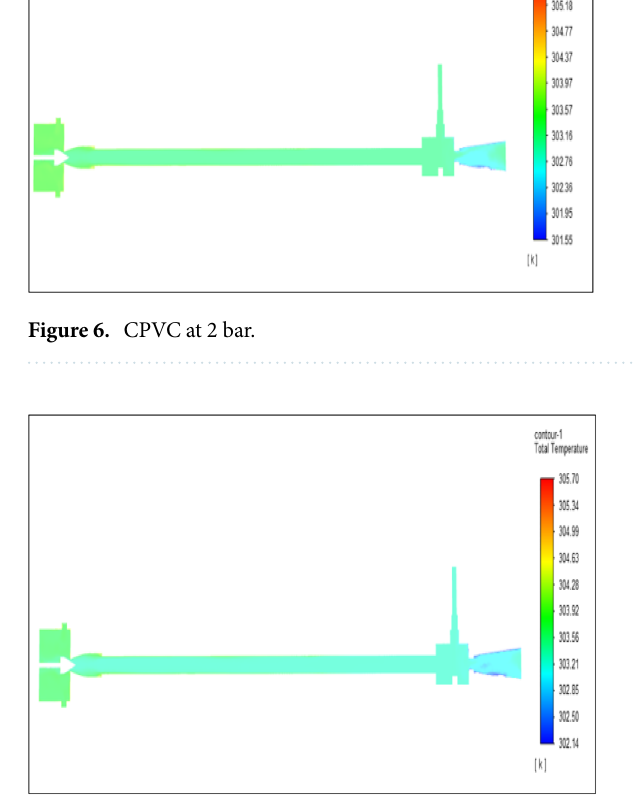
Figure 7. Acrylic at 2 bar.